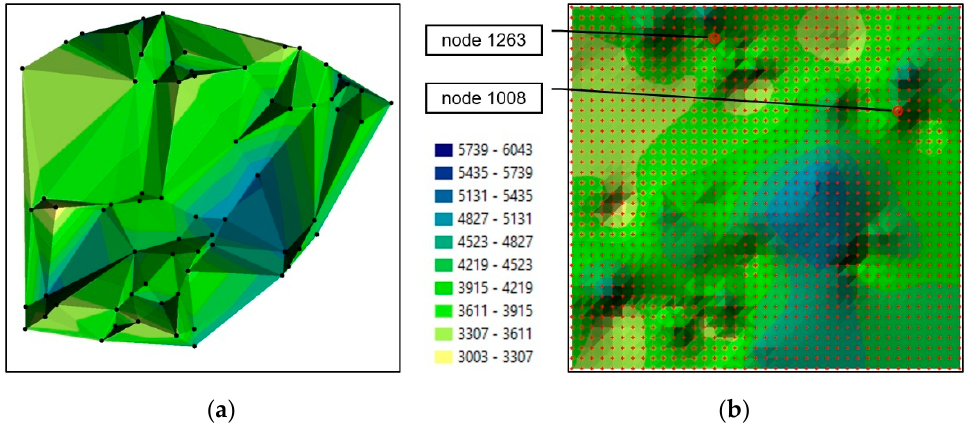
Figure 3. A comparison of interpolation surfaces generated based on 2012 data; ( a ) TIN structure (original measurement data); ( b ) GRID structure with a resolution of 0°.0005 (the analyzed nodes are marked with a circle). Source: own elaboration.